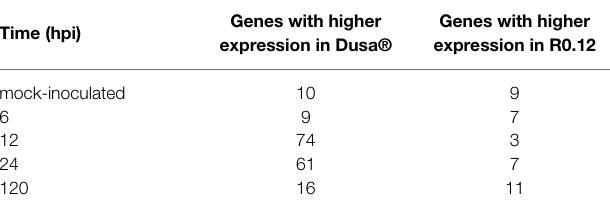
TABLE 3 | Number of PaNLR genes with a significantly higher expression in either the partially resistant (Dusa®) or susceptible (R0.12) avocado rootstock before and following Phytophthora cinnamomi inoculation (hpi, hours post-